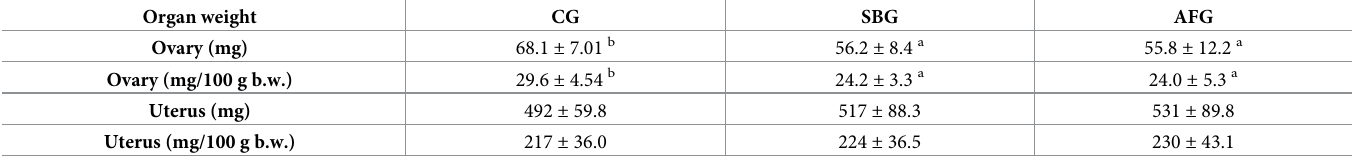
Table 4. Effect of sucrose content diet and alternating feeding on rat ovary and uterus weights. Organ weight Ovary (mg/100 g b.w.) Uterus (mg/100 g b.w.) CG—Control Group, SBG—Sucrose Balanced Group, AFG—Alternately Fed Group a,b -Means marked with different letters in the same line are statistically different, p �